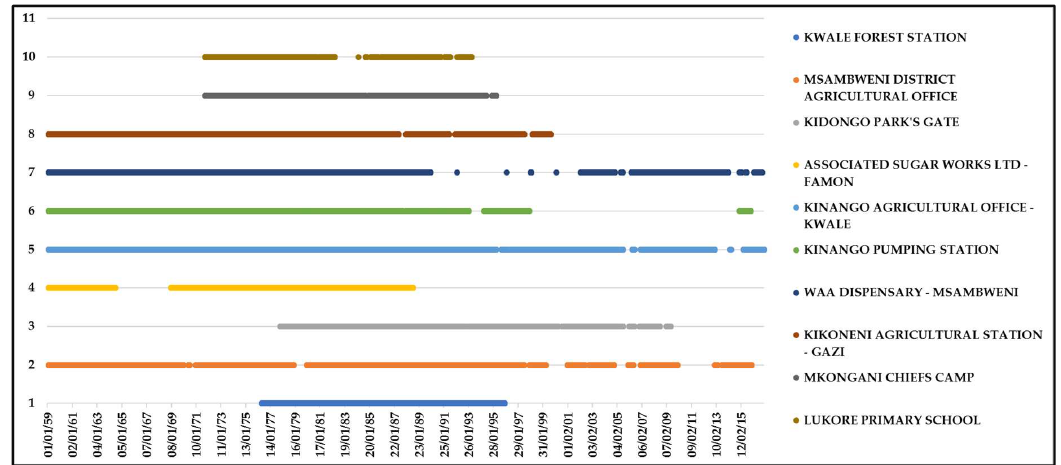
Figure 3 . Rainfall stations data availability graph (Source: Kenya Meteorological Department) . Figure 3. Rainfall stations data availability graph (Source: Kenya Meteorological